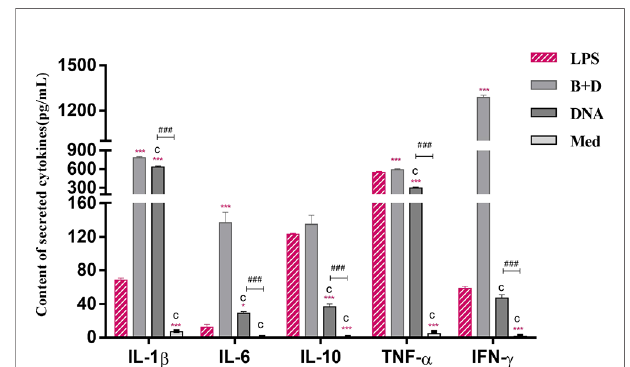
FIGURE 7 | Expression of IL – 1 b , IL – 6, IL – 10, TNF – a , and IFN – g mRNA levels in dendritic cells (DCs). DCs were incubated with pCI – PoRV – VP6 plasmid DNA (1 mg/mL) and bacterial ghosts (BGs) loaded with pCI – PoRV – VP6 plasmid DNA (1000 bacteria/cell) respectively at 37°C for 24 h. Total RNA was extracted. IL – 1 b , IL – 6, IL – 10, TNF – a , and IFN – g mRNA levels were quanti fi ed using RT – qPCR. Values are expressed as the mean ± SD of four individual experiments. Signi fi cance of differences between the LPS, BG +DNA, DNA, and Med groups are represented as follows: *P < 0.05, * *P < 0.01, ***P < 0.001. Letter indicates signi fi cant differences between BG+DNA, DNA, and Med groups: a P < 0.05, b P < 0.01, c P < 0.001. #Asterisk indicates signi fi cant difference between DNA and Med groups: # P < 0.05, ## P < 0.01, ### P < 0.001. n.s., no signi fi cance.